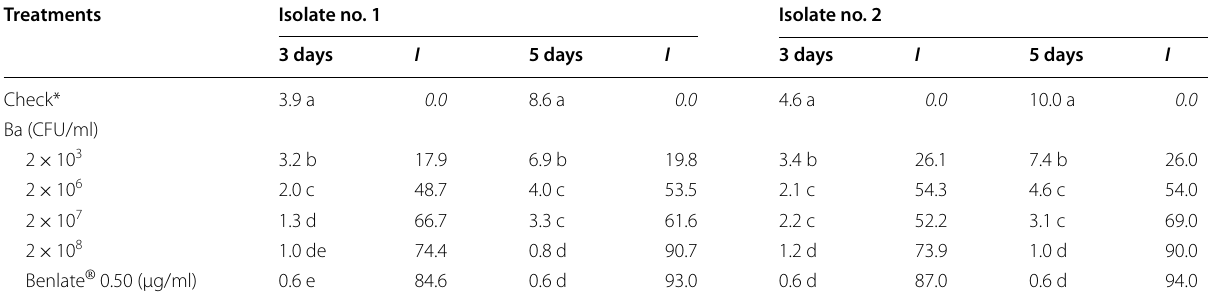
Legend as in Table 1